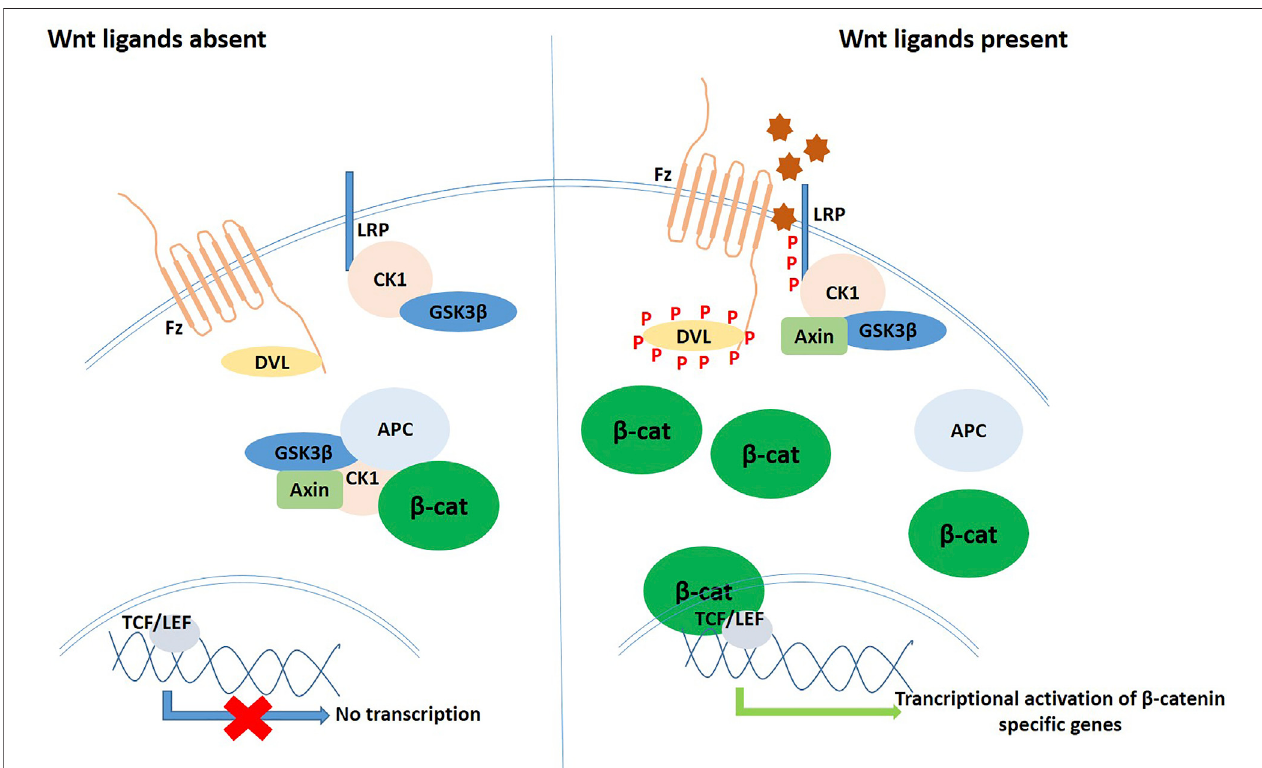
FIGURE 2 | Schematic diagram of the ROS signalling cascade in operation via different modes and pathways.